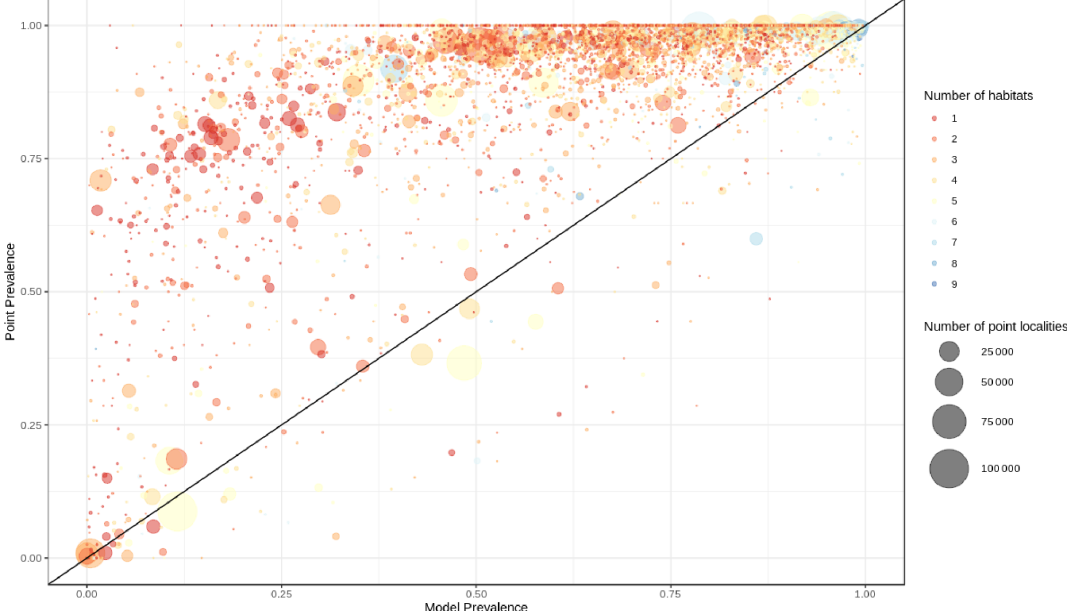
Figure 3. Point prevalence vs. model prevalence for terrestrial birds. Colors indicate the number of habitats each species is coded to, size of circles indicates the number of point localities.